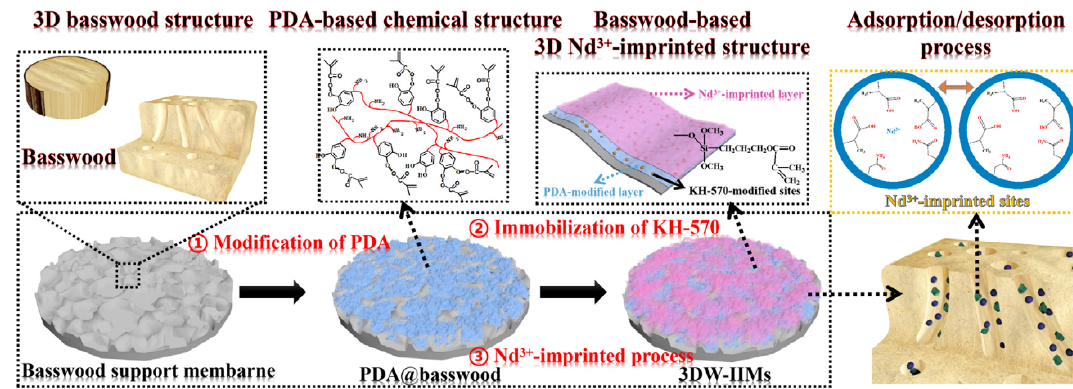
Figure 8. Synthesis route for 3DW-IIMs preparation. Reproduced from the work in [82] with permission from Elsevier.